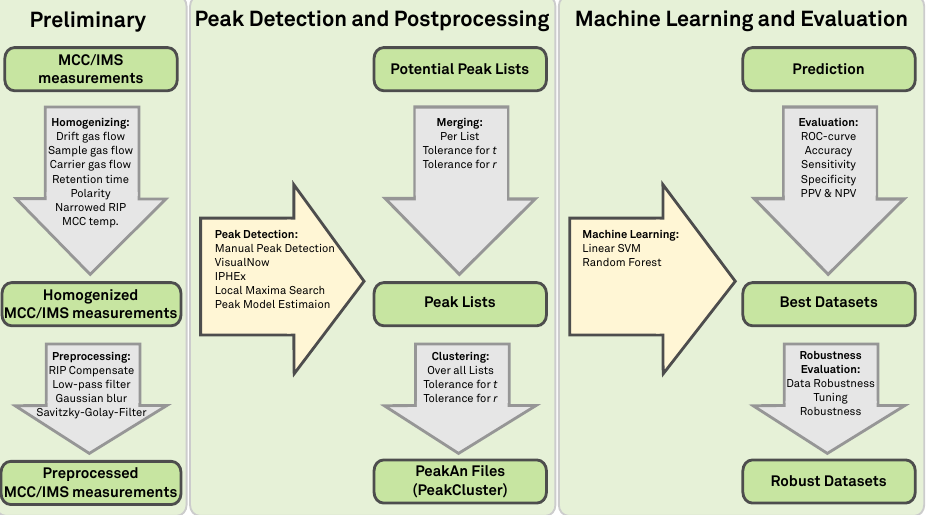
Figure 2. Overview: Evaluation